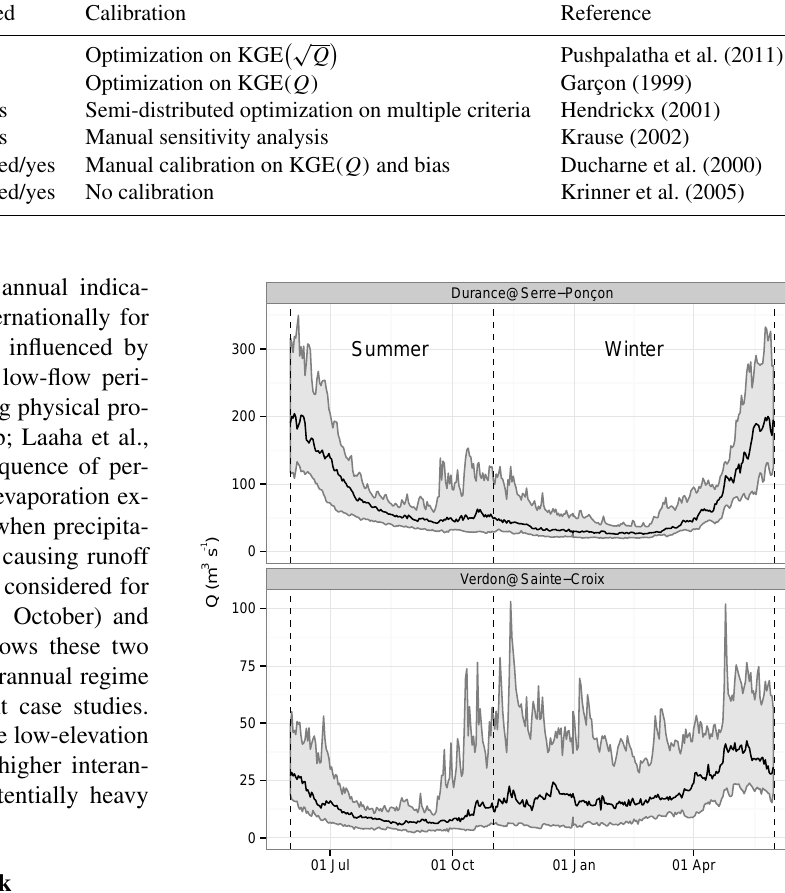
Figure 2. Daily interannual regime of naturalized streamflow over the REF period for the two catchment case studies, and season boundaries for low-flow analysis. Grey ribbons frame the first and last deciles and the black line shows the median